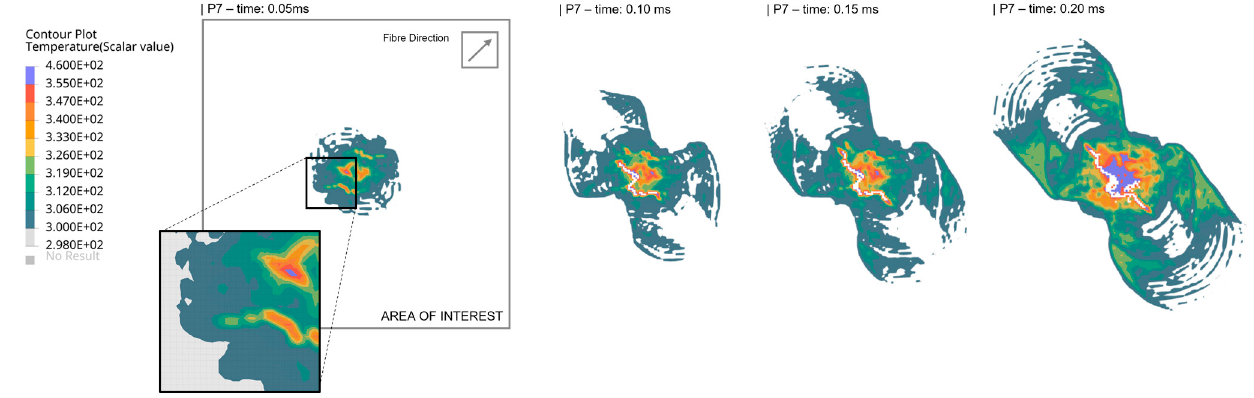
Figure 11. Temporal thermal gradient (Unit Kelvin) evolution observed in speci fi c composite ply (P7).